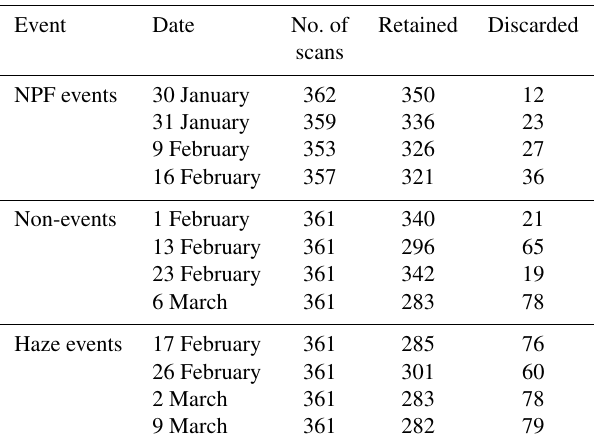
Table 1. List of selected days for analysis, including their event type, the number of scans and the retention rate. All data were mea- sured in